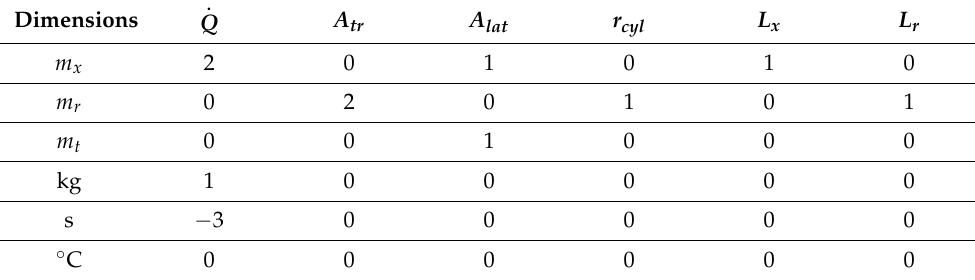
Table 3. The quantities required by experiments (part of matrix B).